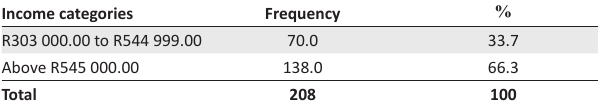
TABLE 9: Characteristic five: Income categories of